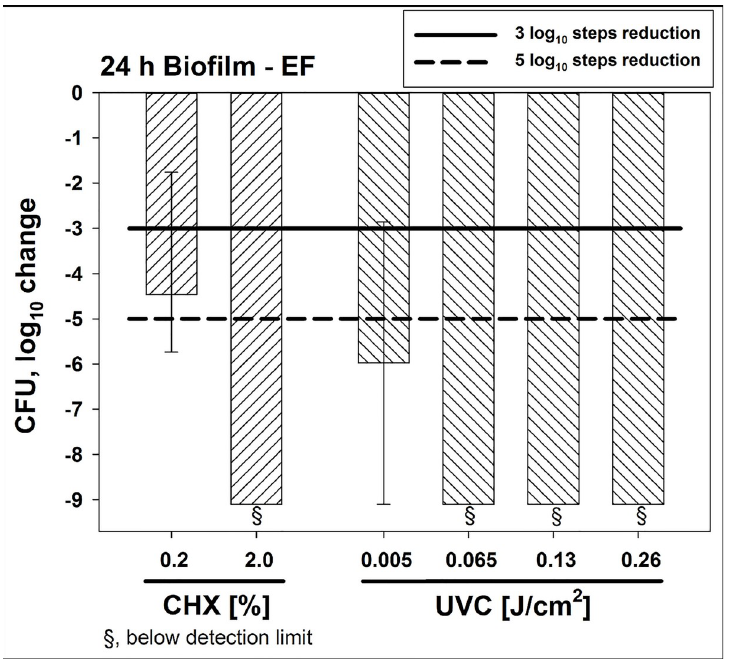
Fig 4. Antimicrobial efficacy of positive controls CHX and UVC radiation towards E . faecalis biofilms cultured for 24 h. Biofilms were incubated with CHX (0.2% or 2%) for 5 min. UVC radiation was performed applying distinct radiation doses (0.005 J/cm 2 , 0.065 J/cm 2 , 0.13 J/cm 2 or 0.26 J/cm 2 ). All results are depicted as medians, 1 st and 3 rd quartiles from six independent experiments in duplicates on a log 10 -scaled ordinate. Bars show the reductions of CFU in a log 10 scale in comparison to untreated controls. Solid and dashed lines exhibit 3 log 10 steps (99.9%) or 5 log 10 reduction (99.999%) of CFU, respectively. ( n = 6; untreated controls exhibited 7.3 x 10 10 CFU in median).